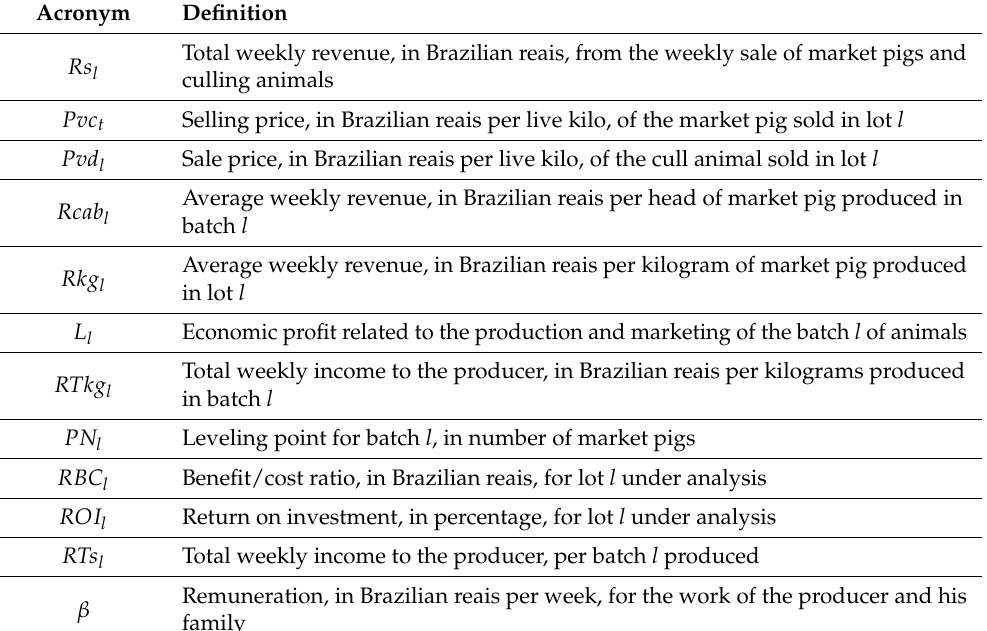
Table 11. Acronyms and definitions of formulas used to calculate the economic indicators that compose the calculation model for swine